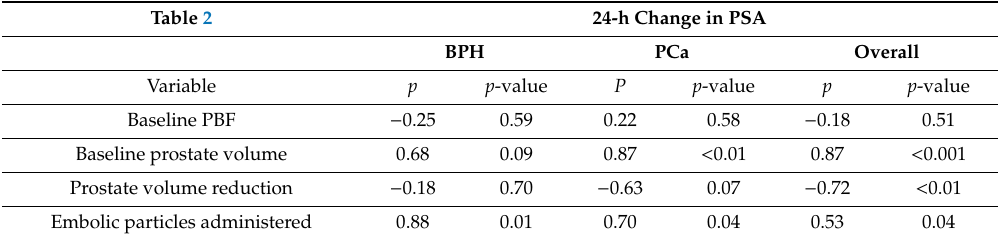
Table 2. Correlation coe ffi cients between 24-h change in PSA and variables. Table